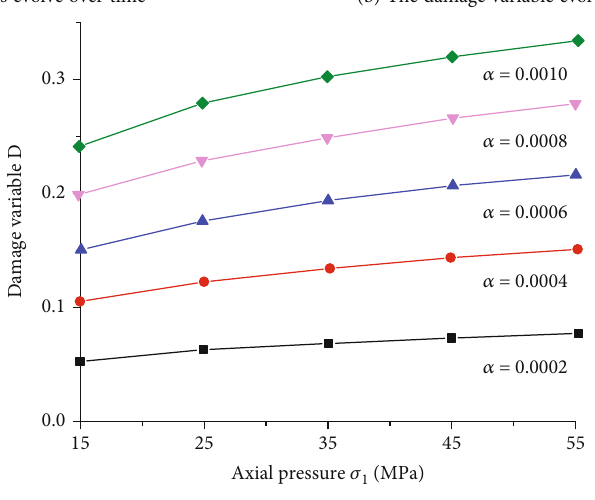
Figure 6: The relation curve between D and σ